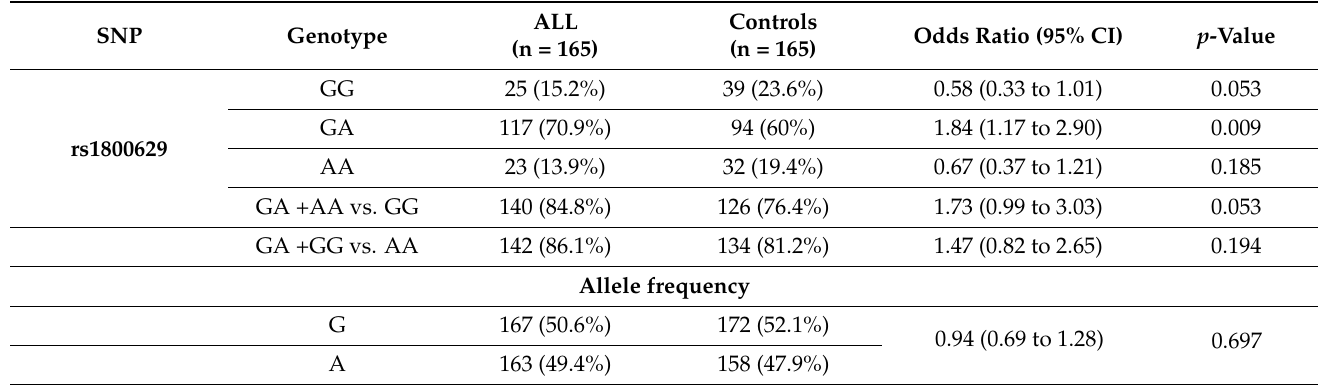
Table 2. The genotype distribution and allele frequencies of TNF rs1800629 in the ALL cases and the control group.